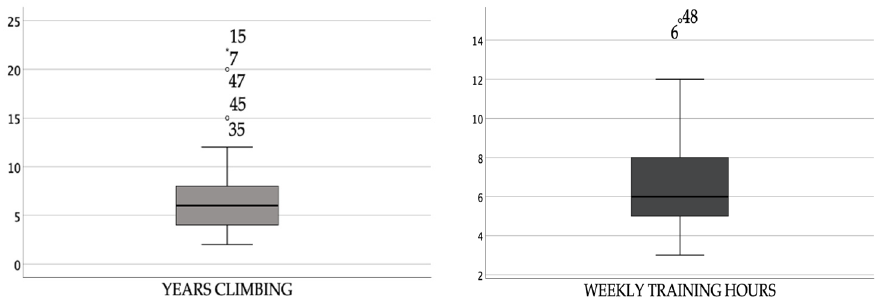
Figure 1. Frequency of years climbing and hours of training. YEARS CLIMBING (the values of the first and third quartiles are 4 and 8, respectively, with a median of 6. The upper whisker is 22, while the lower whisker is 2. Its mean is 7.06); WEEKLY TRAINING HOURS (the values of the first and third quartiles are 5 and 8, respectively, with a median of 6. The upper whisker is 25, while the lower whisker is 3. Its mean is 6.60), extreme cases.